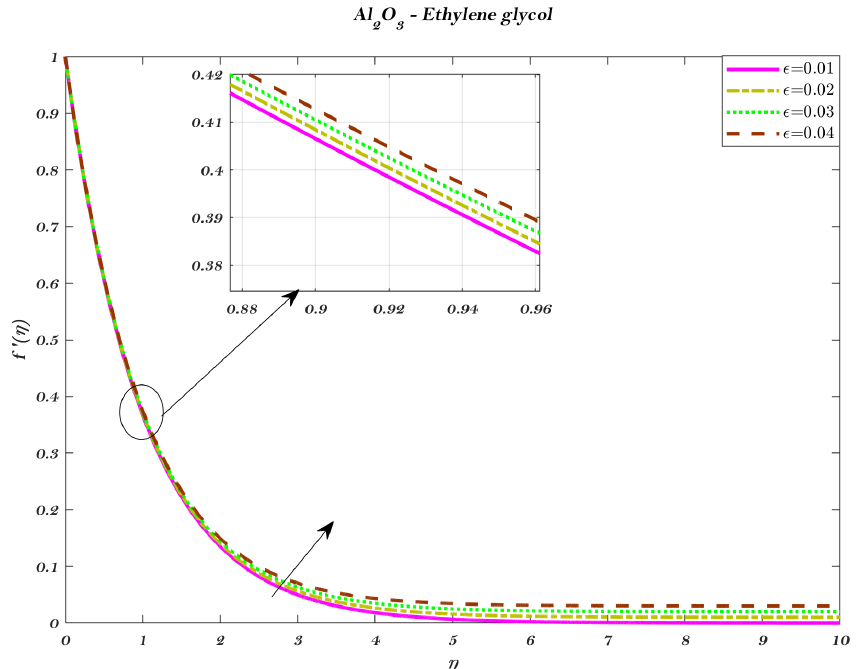
Figure 15. The effect of the stagnation parameter (cid:101) on the velocity profile with fix parameter ϕ = 3%, P r = 204 and ˘ a =